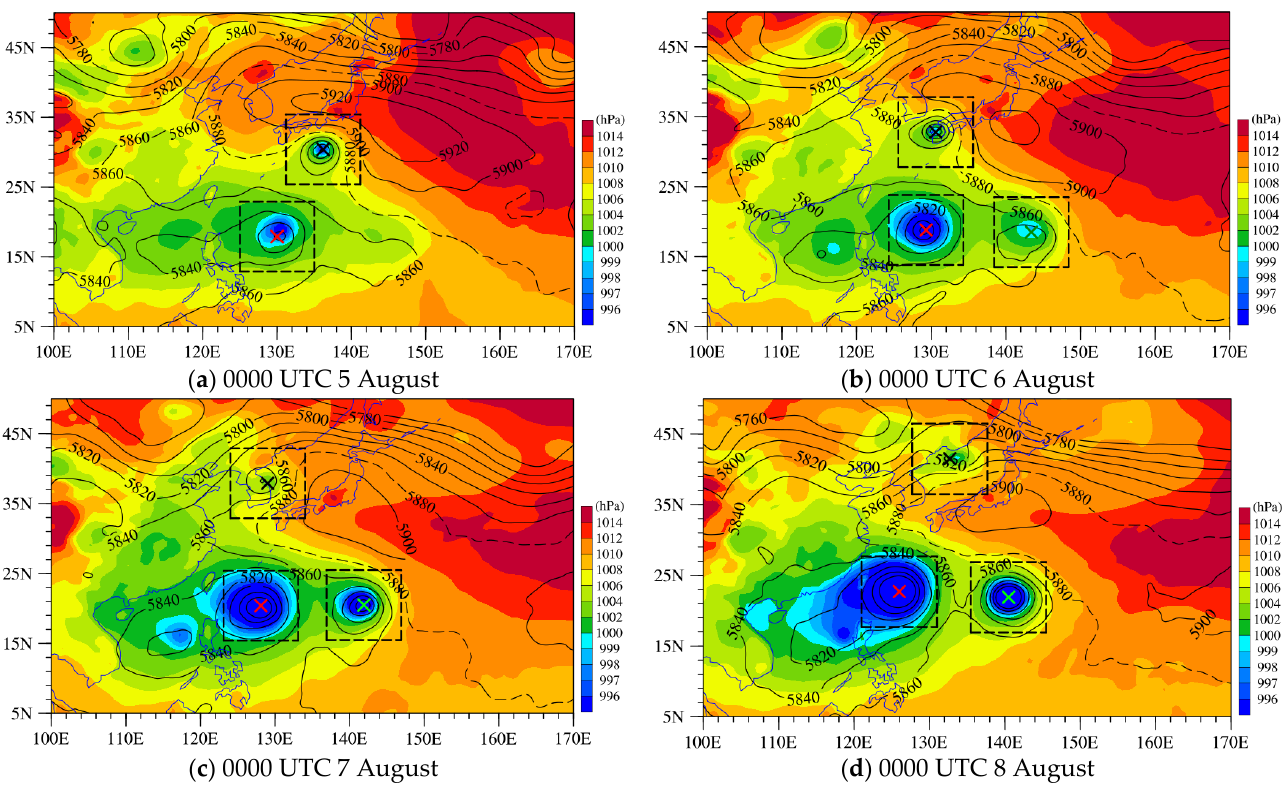
Figure 3. ( a – d ) The ERA-5 mean sea level pressure (color shading) and 500-hPa geopotential height (black curves) at 0000 UTC from 5 to 8 August 2019 for Typhoon Francisco (black cross), Lekima (red cross), and Krosa (green cross). The 10° × 10° boxes (black) of typhoon centers are depicted to show the regions where the temperature anomalies are calculated.